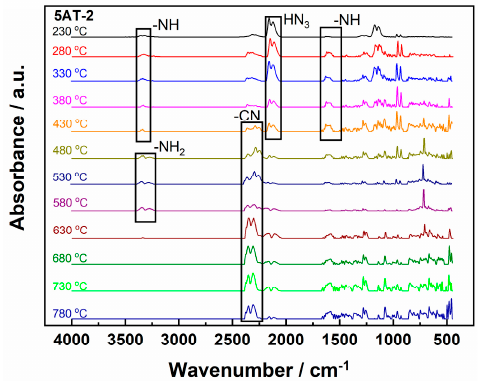
Figure 12. The IR spectrum of 5AT–2.